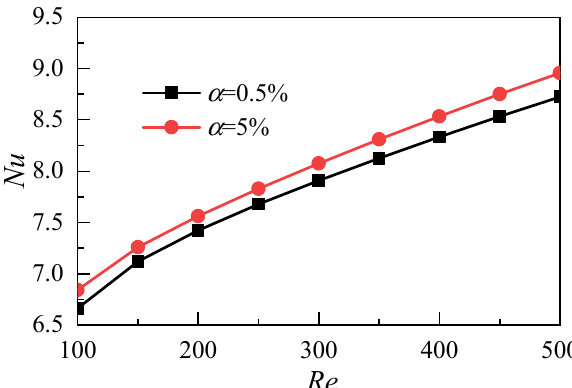
Figure 5. Effects of nanoparticle volume fraction on heat transfer coefficients.